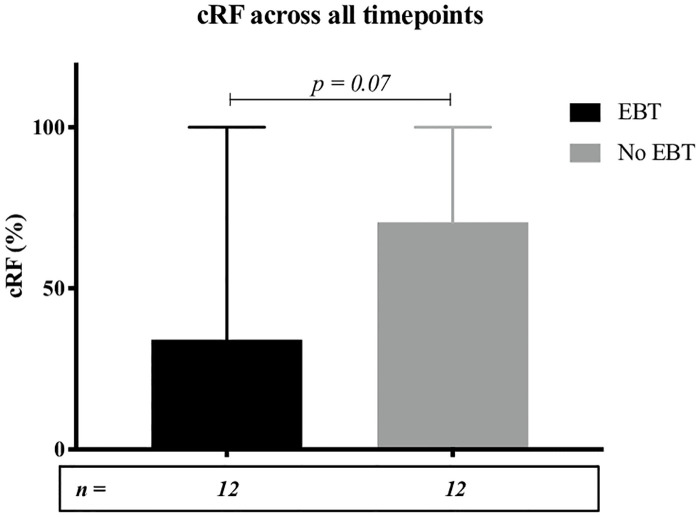
Median cRF(%) across all timepoints with and without EBT.Error bars represent range.